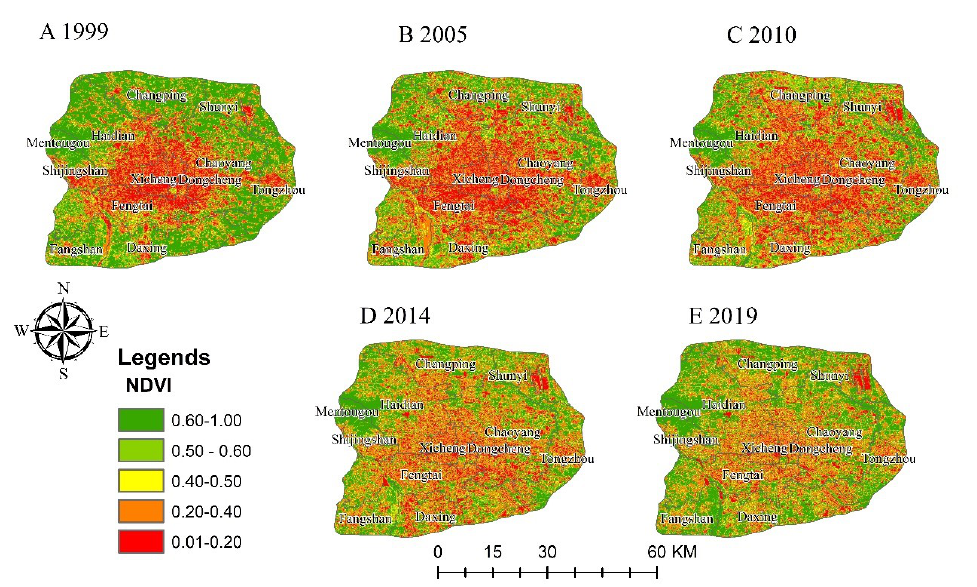
Fig. 6 NDVI in Beijing from 1999 to 2019. NDVI, normalised difference vegetation index.